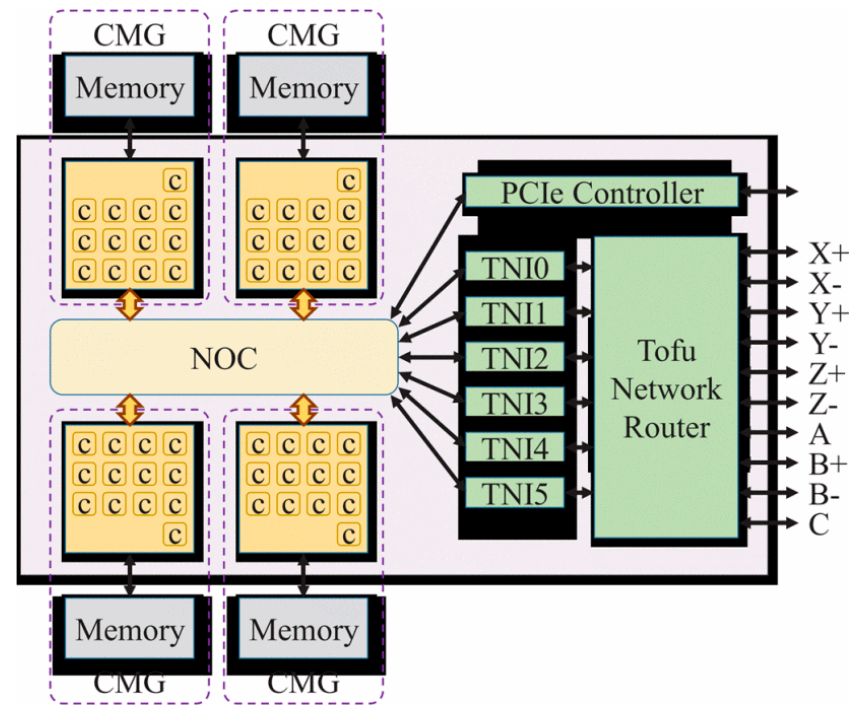
Figure 6. NoC Structure of the A64FX compute nodes [10].